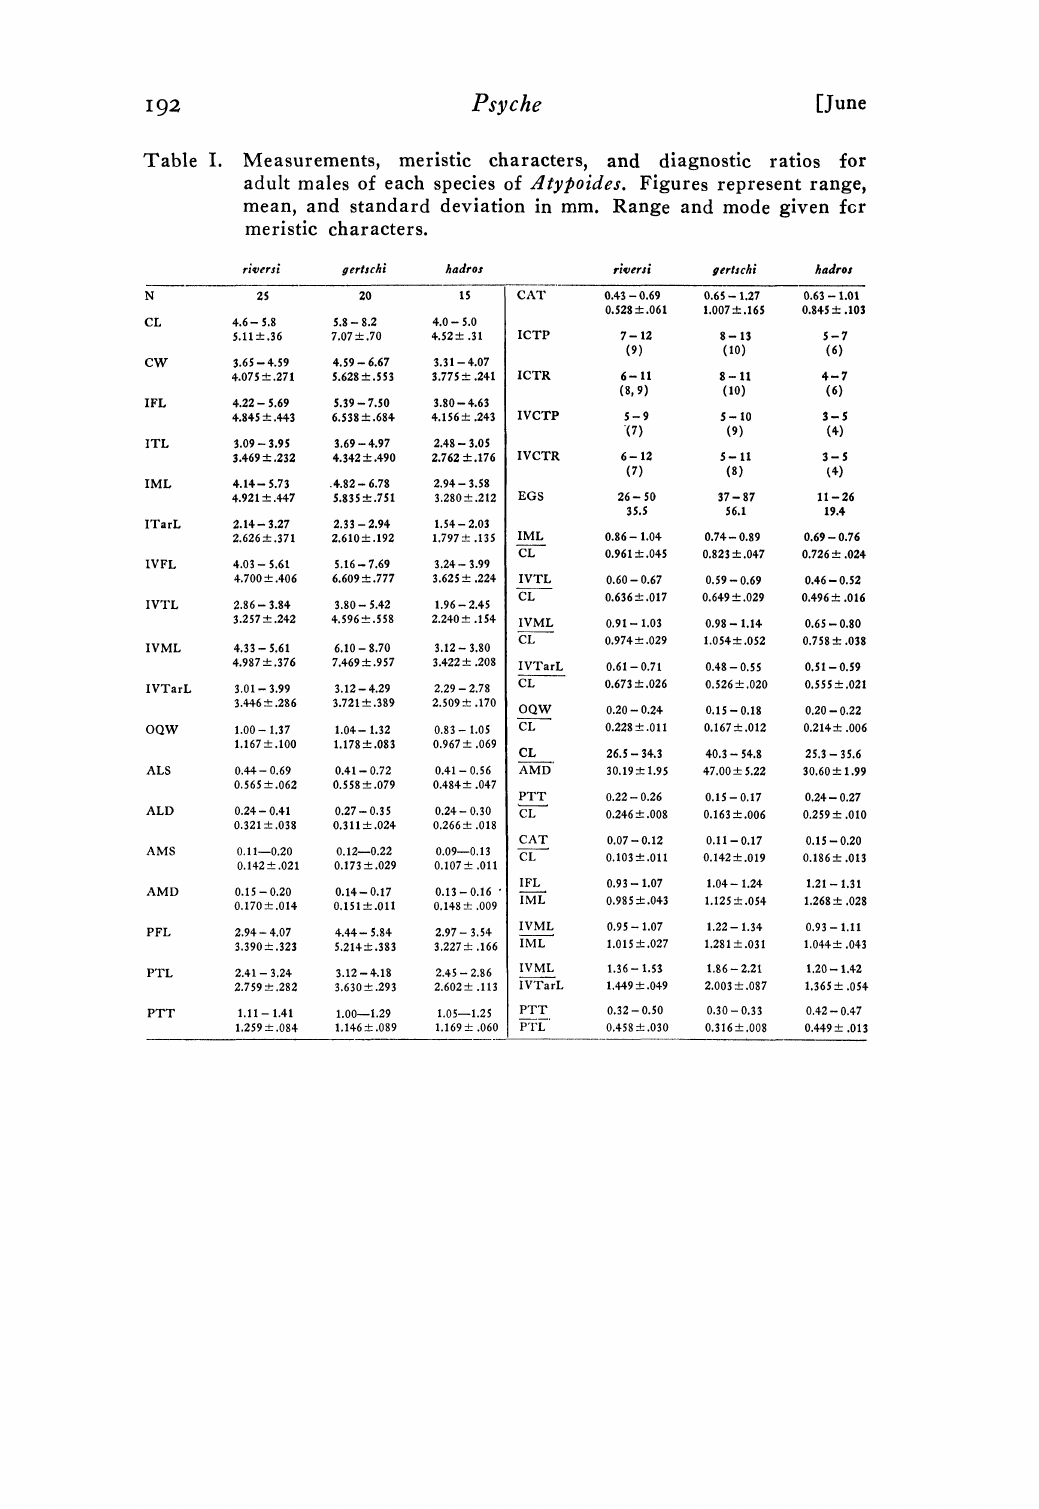
Table I. Measurements, meristie characters, and diagnostic ratios for adult males of each species of Atypoides. Figures represent range, mean, and standard deviation in ram. Range and mode given fcr meristic